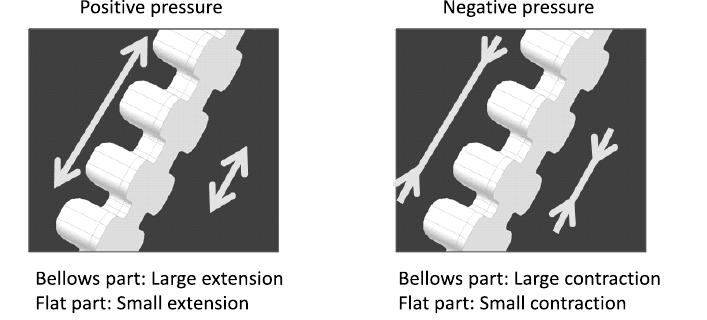
Figure 1. The principle of